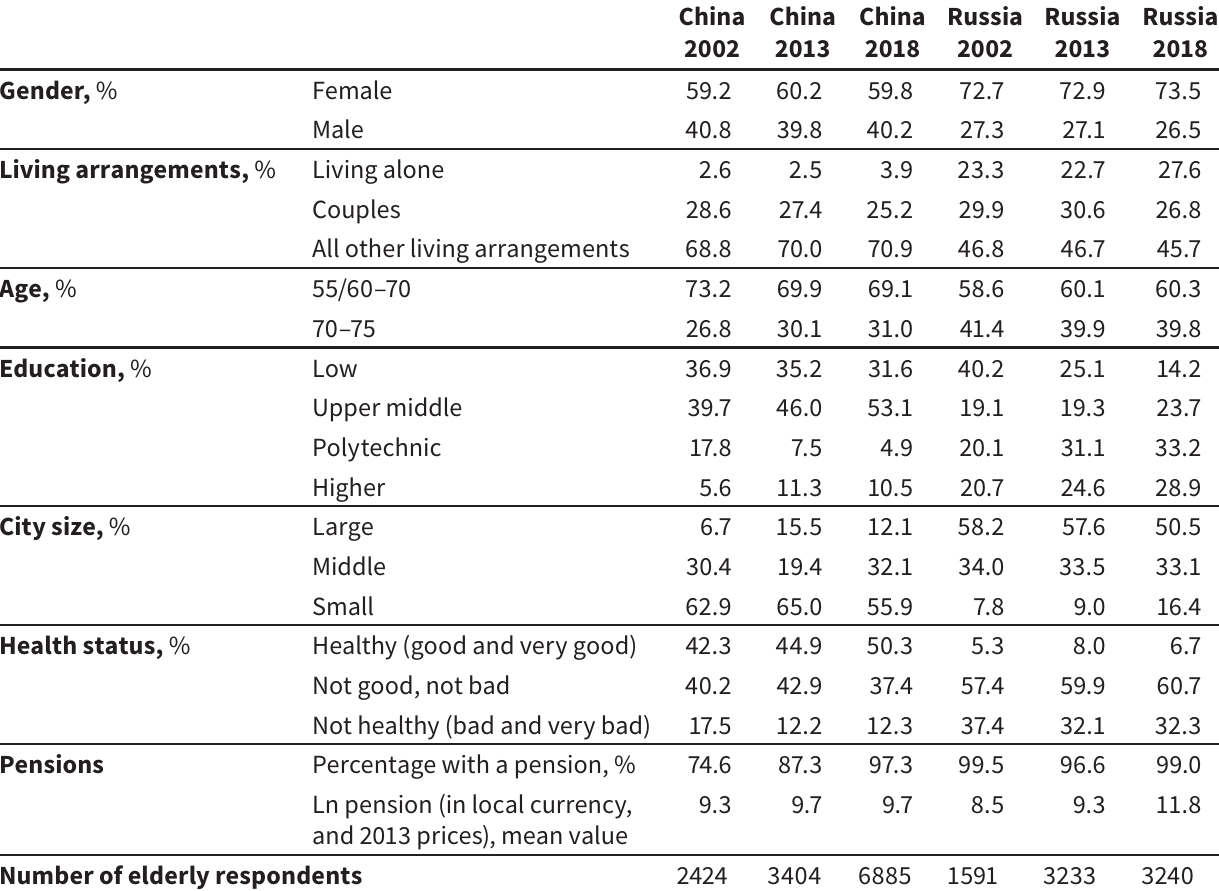
Table 1 Older people in urban China and urban Russia in 2002, 2013, and 2018 by characteristics